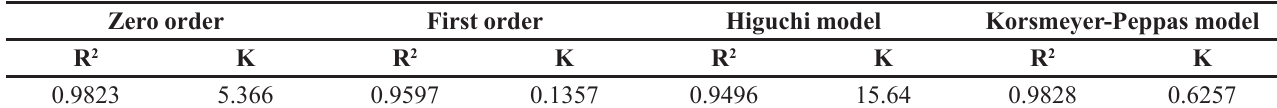
TABLE IV - Release kinetics of irbesartan-loaded SLN F3 Zero order